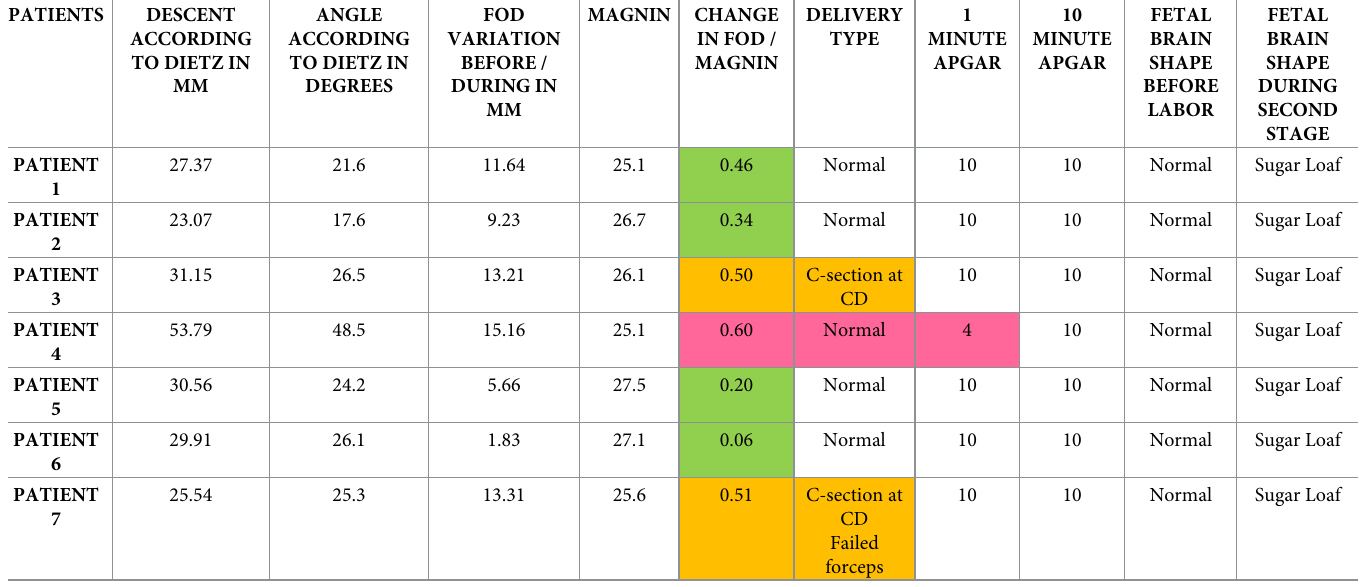
Table 2. Fetal head molding quantitative evaluation during the second stage of labor. FOD: fronto-occipital diameter; Δ FOD: FOD before labor—FOD during second stage of labor (mm); CD: complete dilation. Green color = smaller Δ FODs AND normal delivery; orange color = intermediate Δ FODs AND emergency C-sections; pink color = greatest Δ FOD AND normal